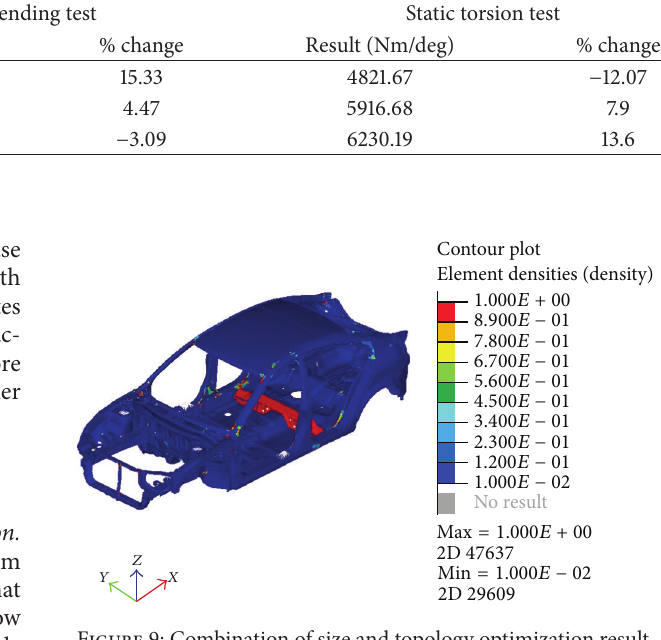
Figure 9: Combination of size and topology optimization